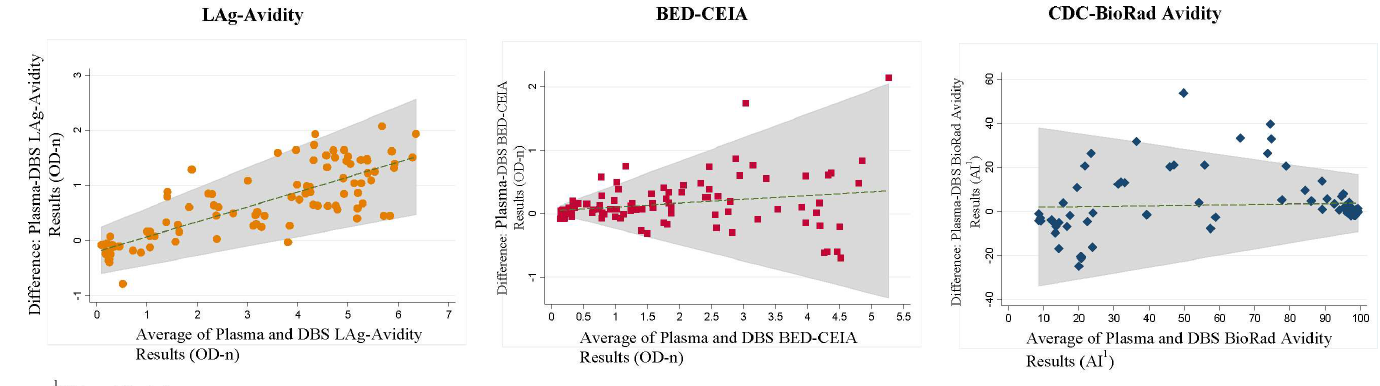
Fig 2. Bland-Altman plots of results obtained from testing matched plasma and DBS samples with LAg-Avidity, BED-CEIA, and CDC-BioRad Avidity.